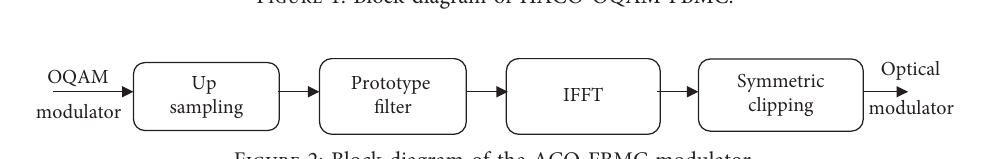
Figure 1: Block diagram of HACO-OQAM-FBMC.